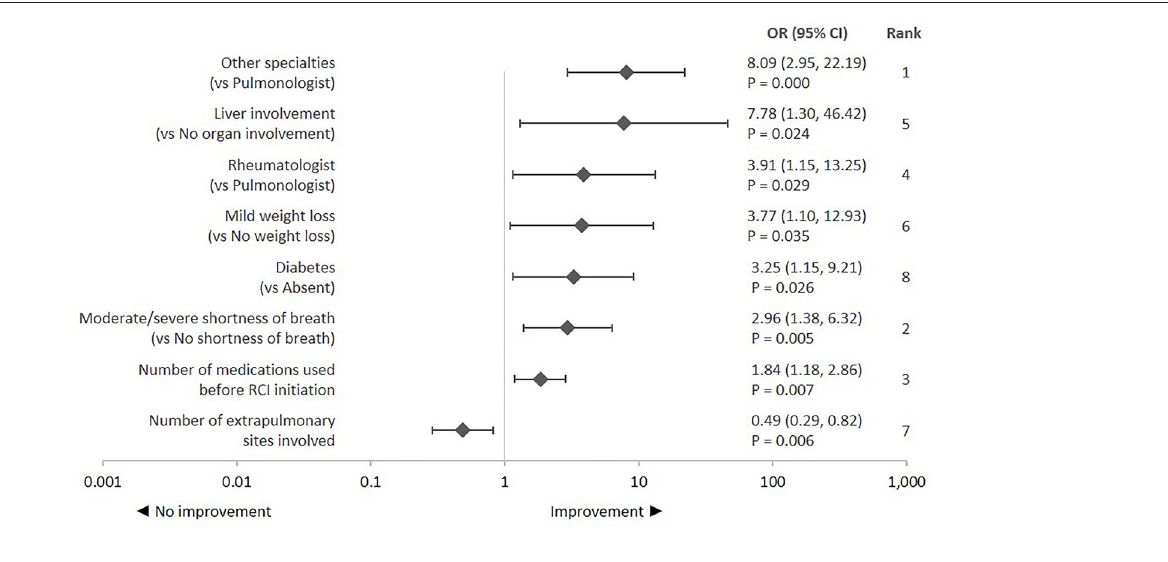
Figure 4. Predictors of Improvement in Treatment-Related Outcomes: Corticosteroid Discontinuation or